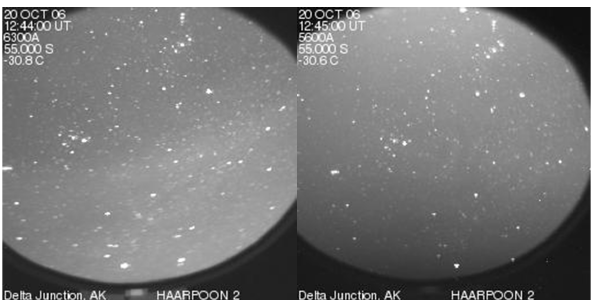
Fig. 9. Star field images from a deployed HAARPOON system in operation in Alaska. The horizon is near the top of the images, with vertical near the bottom. Note the slight deterioration in focus near the bottom of the image on the left, which corresponds to the more distant upper part of the tilted